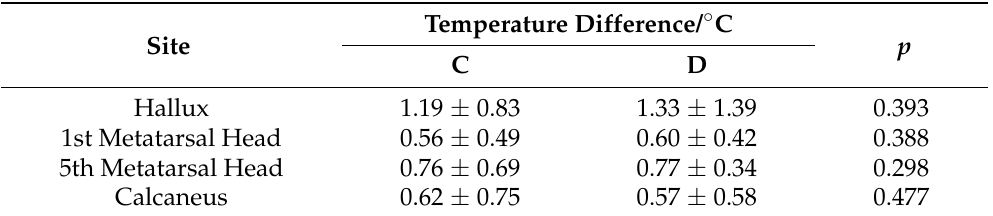
Table 2. Values of temperature differences between groups during the sitting stage. Control group participants (C), participants with diabetes (D). Values are mean ± SD. * p <